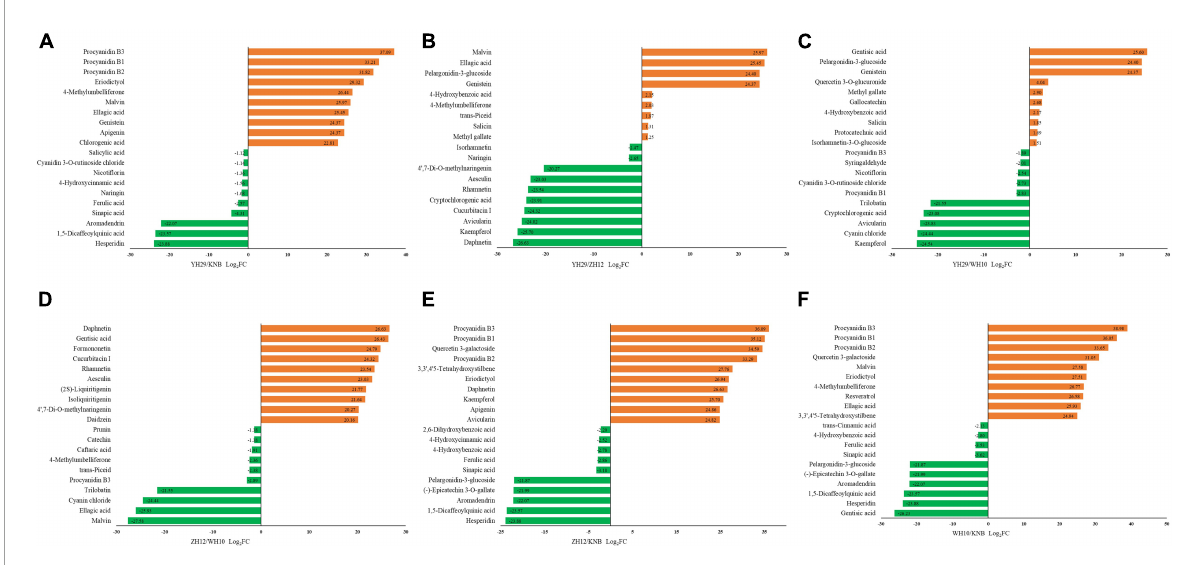
FIGURE4 Top 20 differentially accumulated metabolites (DAMs) among the six pairwise groups of the fold change. (A) YH29 and KNB; (B) YH29 and ZH12; (C) YH29 and WH10; (D) ZH12 and WH10; (E) ZH12 and KNB; and (F) WH10 and